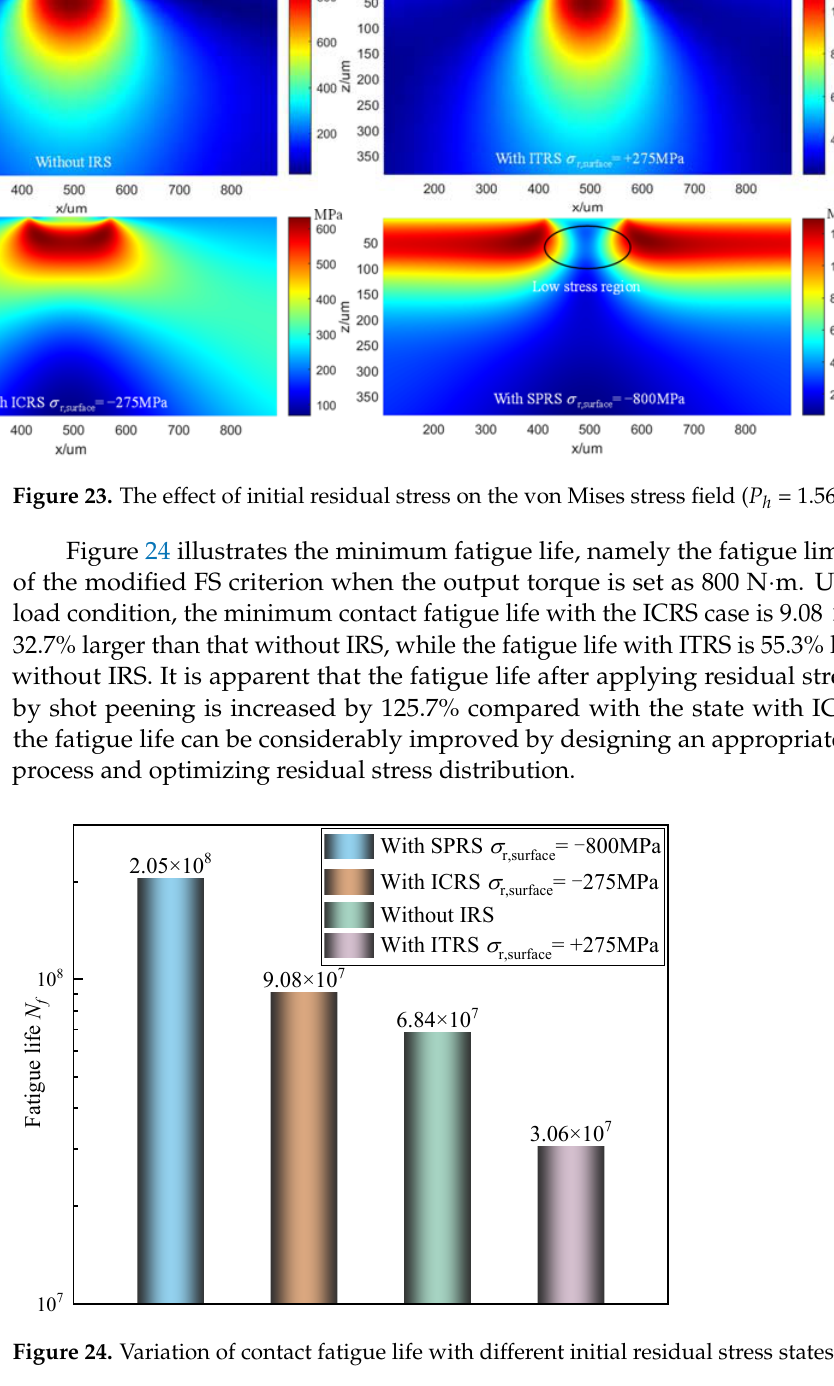
Figure 24. Variation of contact fatigue life with different initial residual stress states ( P h = 1.56 GPa).